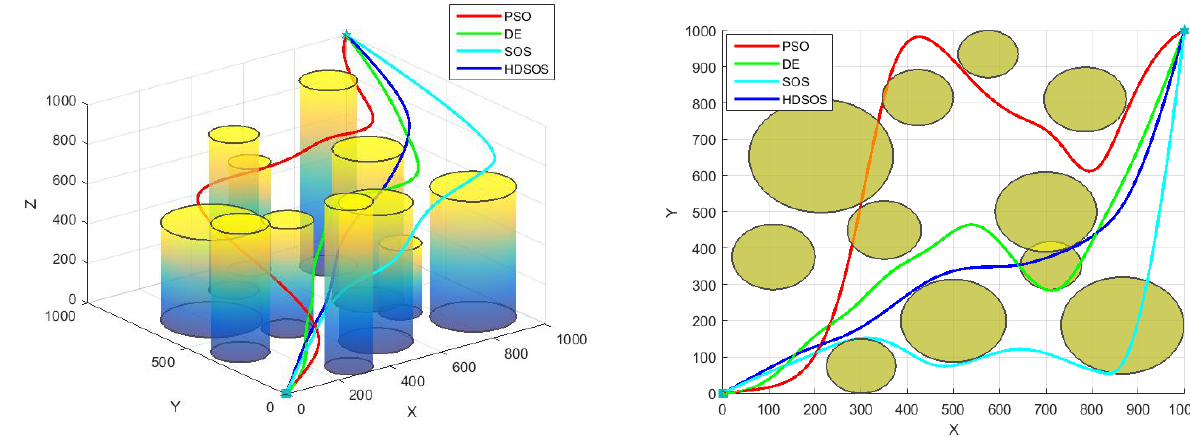
( a ) The path planning results of four algorithms in scenario F. ( b ) X-Y view of the comparison in scenario F.